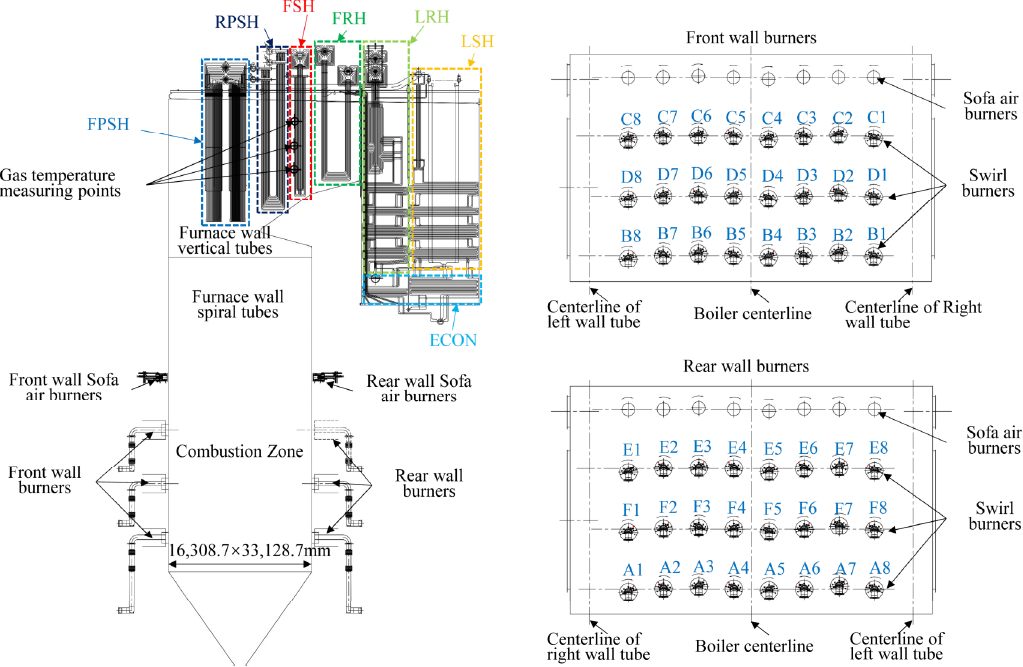
Figure 1. Layout of burners and high-temperature heating surfaces of the 1000 MW USC coal-fired boiler.